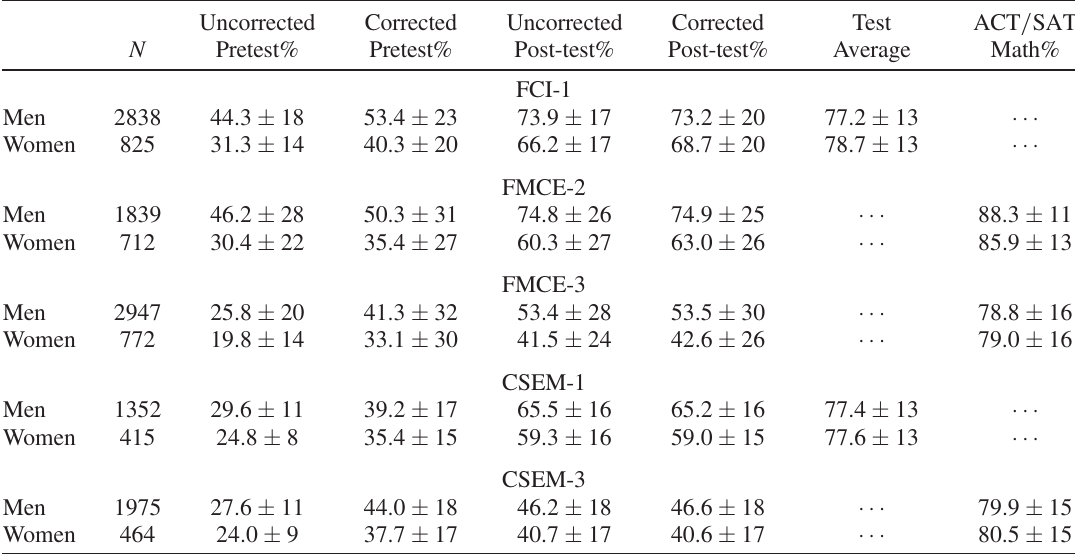
TABLE II. Descriptive statistics. The mean and standard deviation of both the original and corrected instruments. All values are percentages presented as mean (cid:2) standard